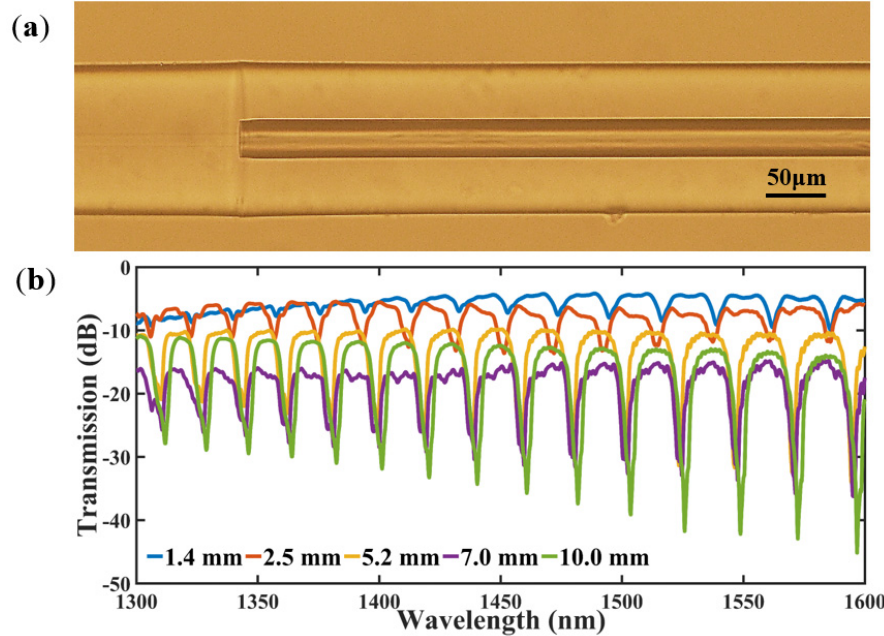
Figure 2. ( a ) A microscope image of a junction between a SMF and an HCF, ( b ) Interference spectrum corresponding to different lengths of HCF.